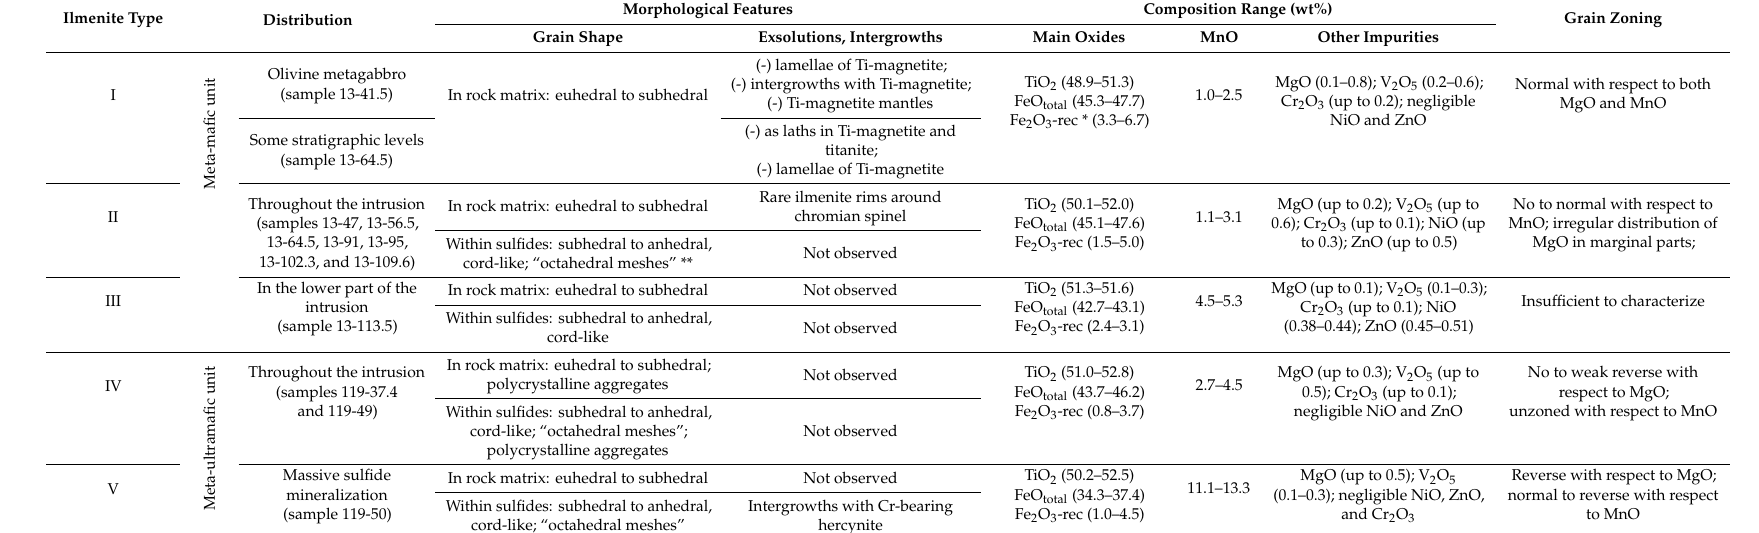
Table 1. Classification of ilmenite types from metamorphosed mafic-ultramafic rocks of the Sedova Zaimka